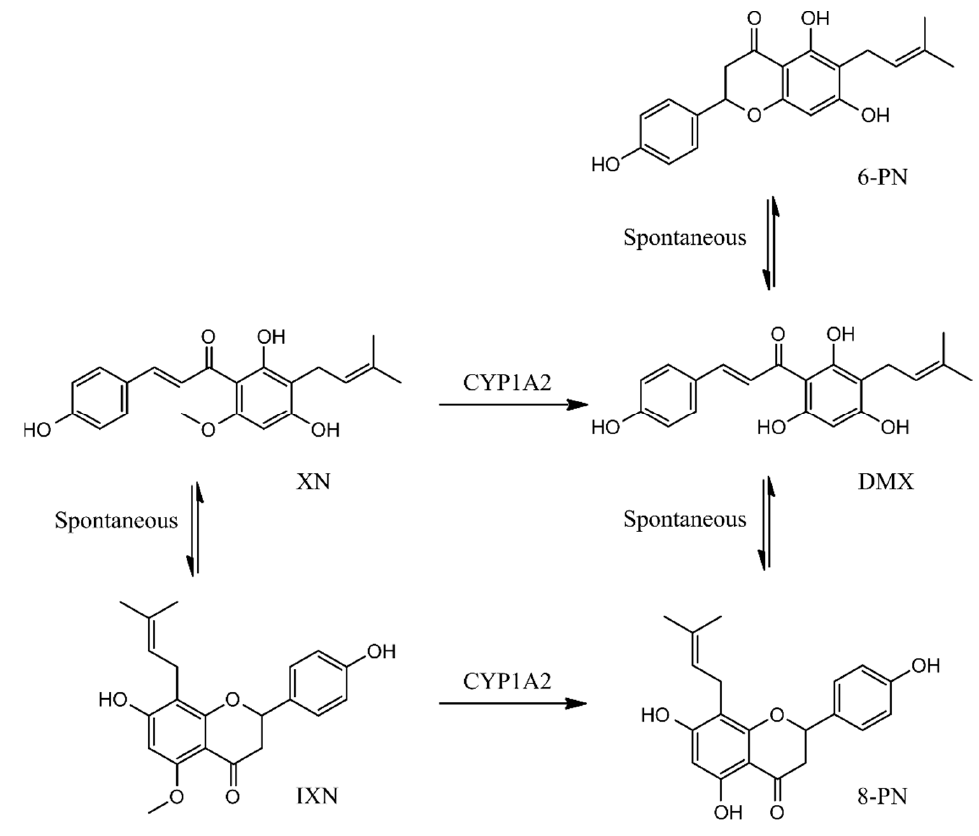
Figure 1. XN conversion into its derivatives: IXN, 6 ‐ PN, 8 ‐ PN, and DMX